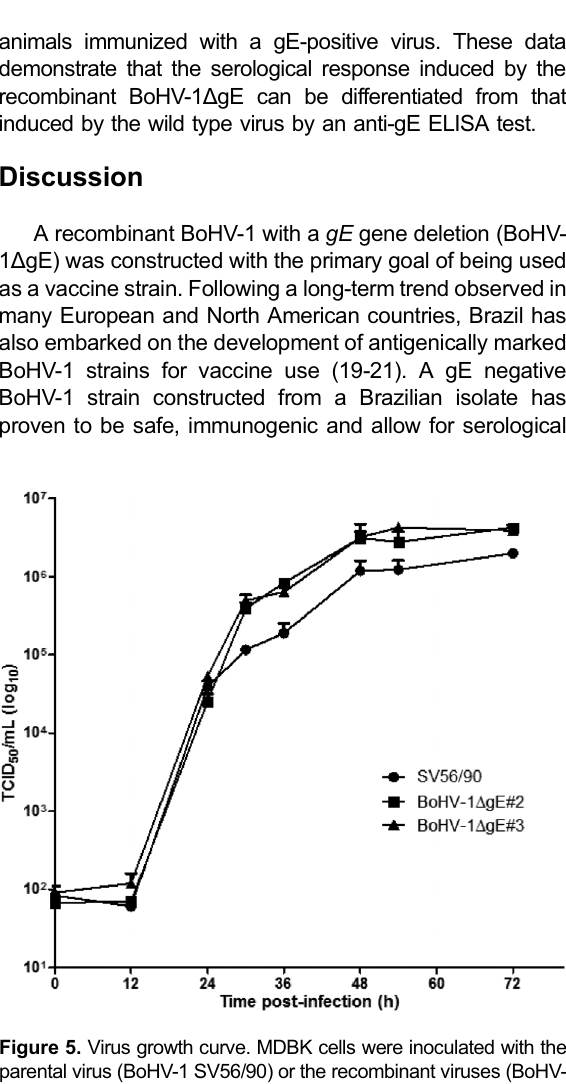
Braz J Med Biol Res 48(9)